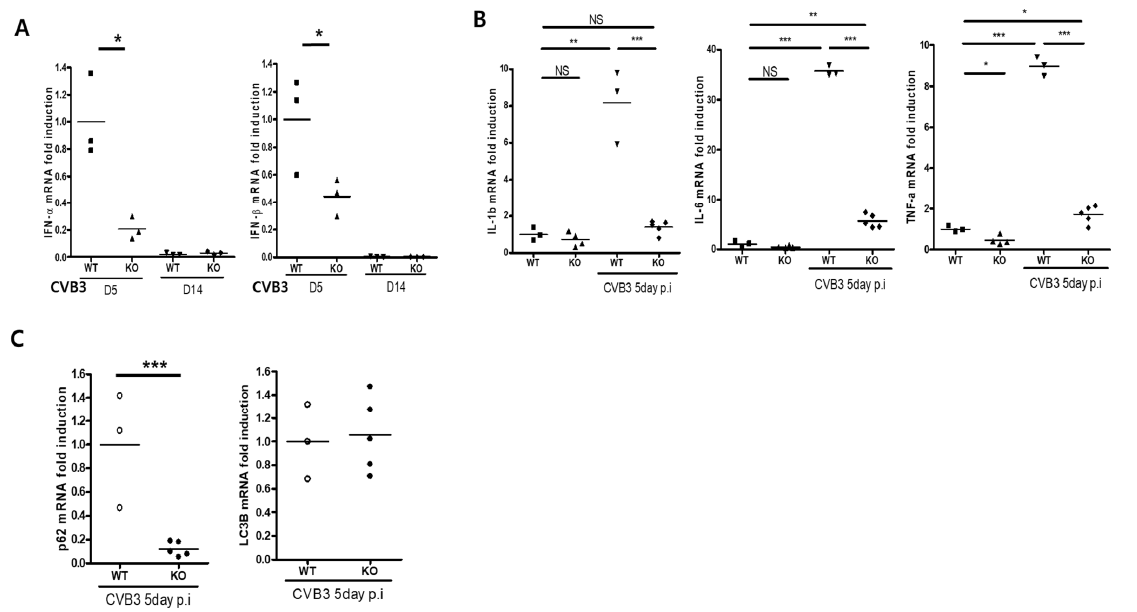
Figure 5. AKT2 deletion attenuates inflammatory cytokines and Type 1 interferon induction. ( A – C ) Total RNA was extracted from WT and KO mouse hearts on Days 5 and 14 p.i. and subjected to real-time PCR with the indicated primer sets. All data are the means ± s.e.m from two independent